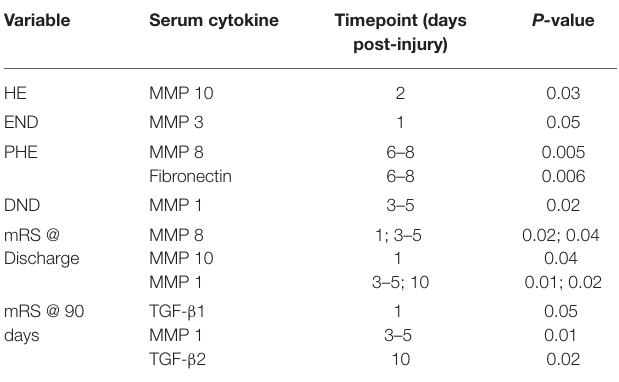
TABLE 2 | Univariate analysis of serum marker associations with clinical and/or radiologic outcome measures. Variable